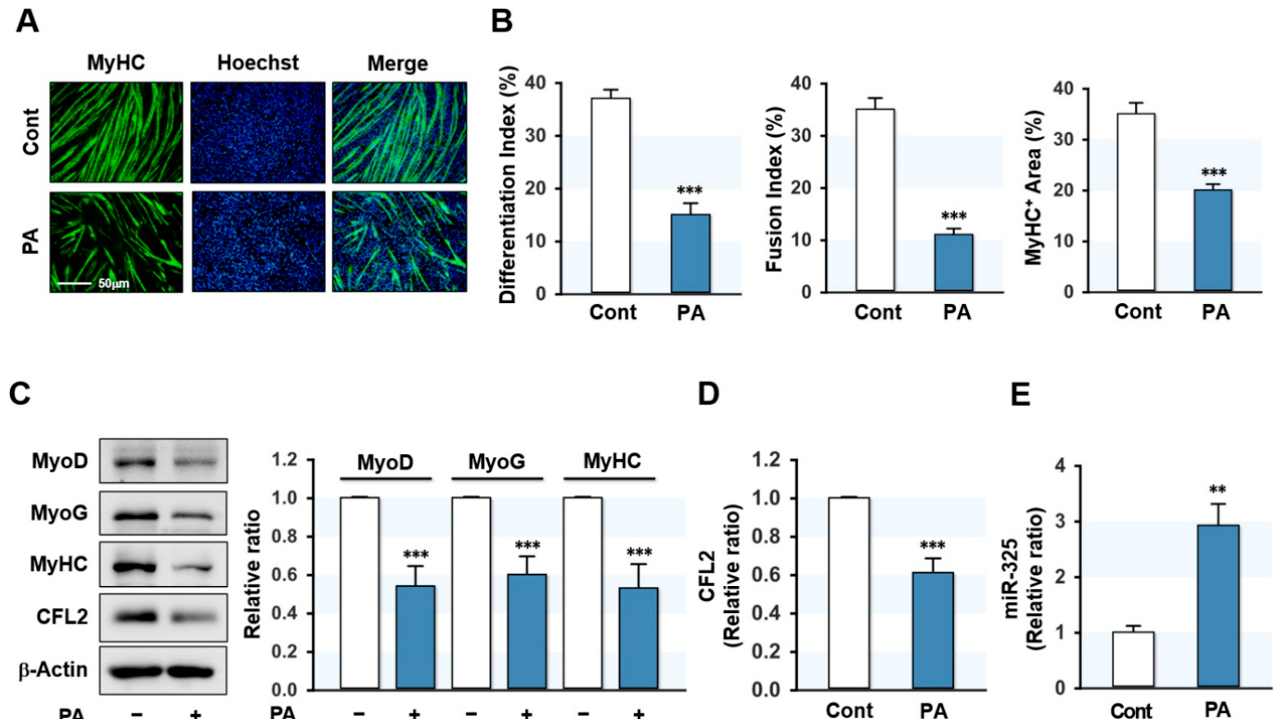
Figure 1. PA inhibited myoblast differentiation but enhanced miR-325-3p expression. ( A ) C2C12 myoblasts were pretreated with BSA-vehicle (Cont) or PA (100 μ M) for 24 h and induced to differentiate for five days. Cells were subjected to immunocytochemistry with MyHC antibody (green) and Hoechst 33342 (blue) to verify differentiation. Scale bar: 50 μ m. ( B ) Quantitative analysis of differentiation index, fusion index, and MyHC-positive area. ( C , D ) After pretreatment with PA, cells were differentiated for three days and immunoblotted with antibodies for myogenic factors (MyoD, MyoG, and MyHC) and CFL2. Intensities were normalized versus β -actin. ( E ) The expressions of miR-325-3p were determined by q RT-PCR and normalized versus U6. Immunoblot and q RT-PCR results are shown as relative ratios versus control. All results are presented as the means ± SEMs ( n > 3), and levels of significance are presented as **, p < 0.01; ***, p < 0.001 vs. controls.